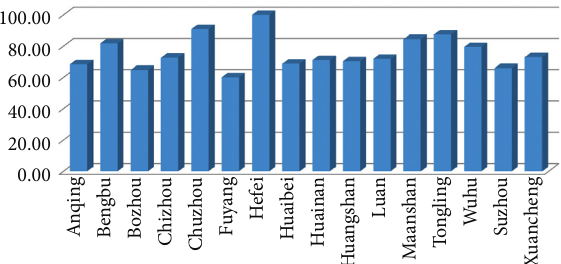
Figure 7: Proportion of fixed assets investment in information industry in social fixed assets investment.